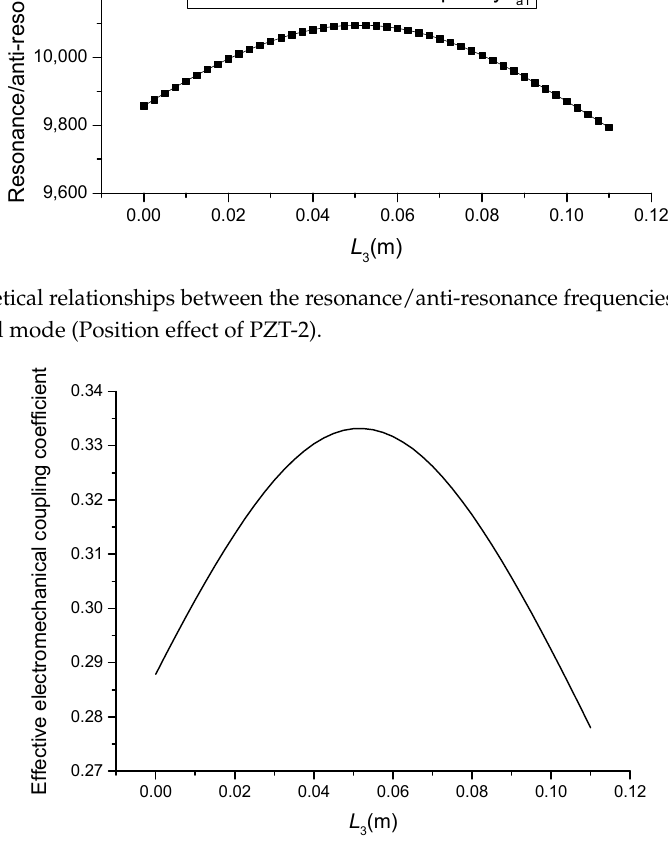
Figure 8. Theoretical relationship between the effective electromechanical coupling coefficient and length L 3 at the fundamental mode (Position effect of PZT-2).